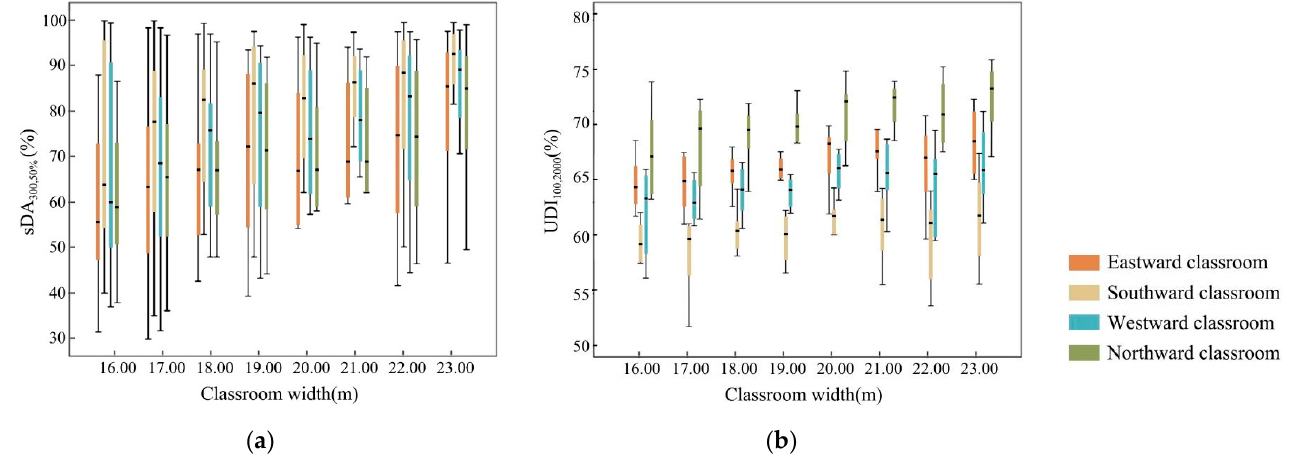
Figure 5. The analysis results of the distribution interval between the classroom width and the evaluation indices: ( a ) the analysis results of sDA 300,50% ; ( b ) the analysis results of UDI 100–2000